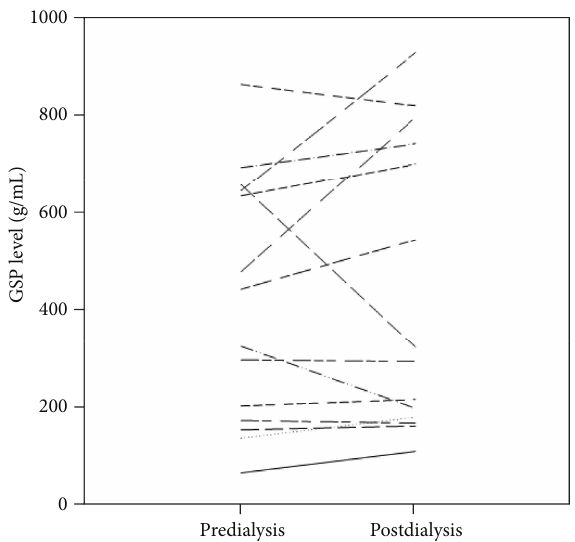
Figure 4: Differences in galactose single-point (GSP) test levels after 1 year of maintenance hemodialysis (HD) among 15 selected patients. The mean ± standard deviation (SD) of the first GSP value was 420.20 ± 175.26 g/mL. The 2nd GSP value after one year of maintenanceHDwas383.40 ± 153.97g/mL,withadifferenceof19.00 ± 37.66 g/mL ( 𝑃 < 0.05